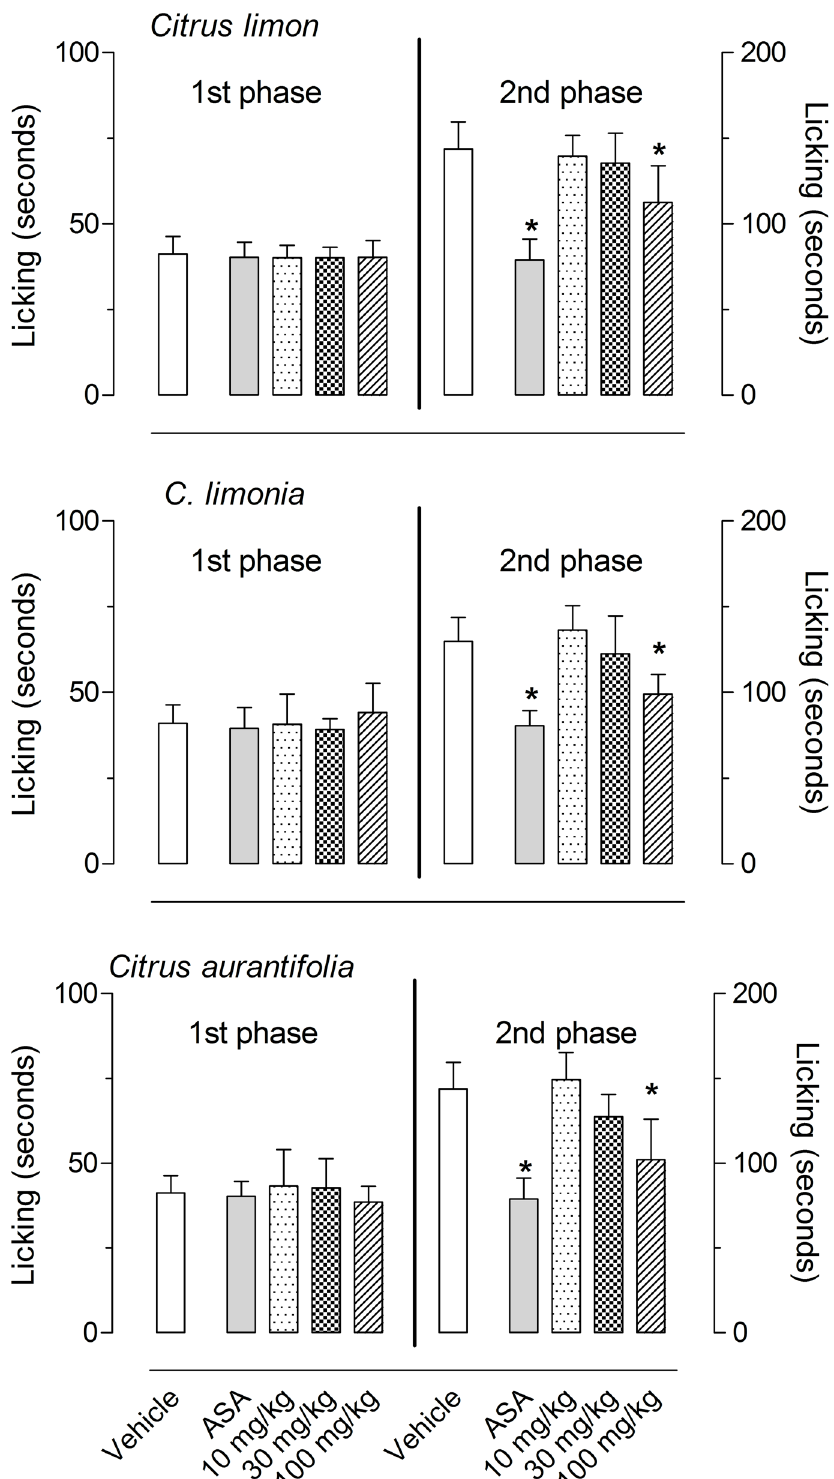
Fig 2. Effects of C . limon , C . limonia and C . aurantifolia essential oils on the formalin-induced licking response in mice. Animals were pre-treated with oral doses (10, 30 or 100 mg/kg) of each essential oil, acetylsalicylic acid (ASA, 100 mg/kg) or vehicle. The results are presented as the mean ± S.D. (n = 7 per group) of the time that the animal spent licking the formalin-injected paw. Statistical significance was calculated by ANOVA followed by Bonferroni's test. * P < 0.05 when compared to vehicle-treated